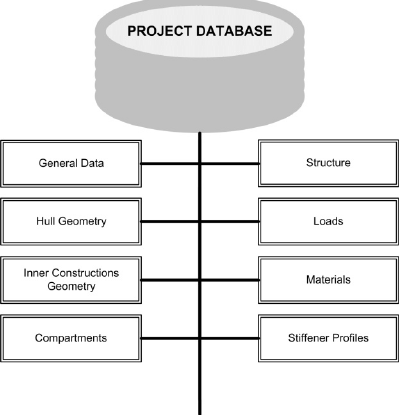
Figure 13. The structure of project database.